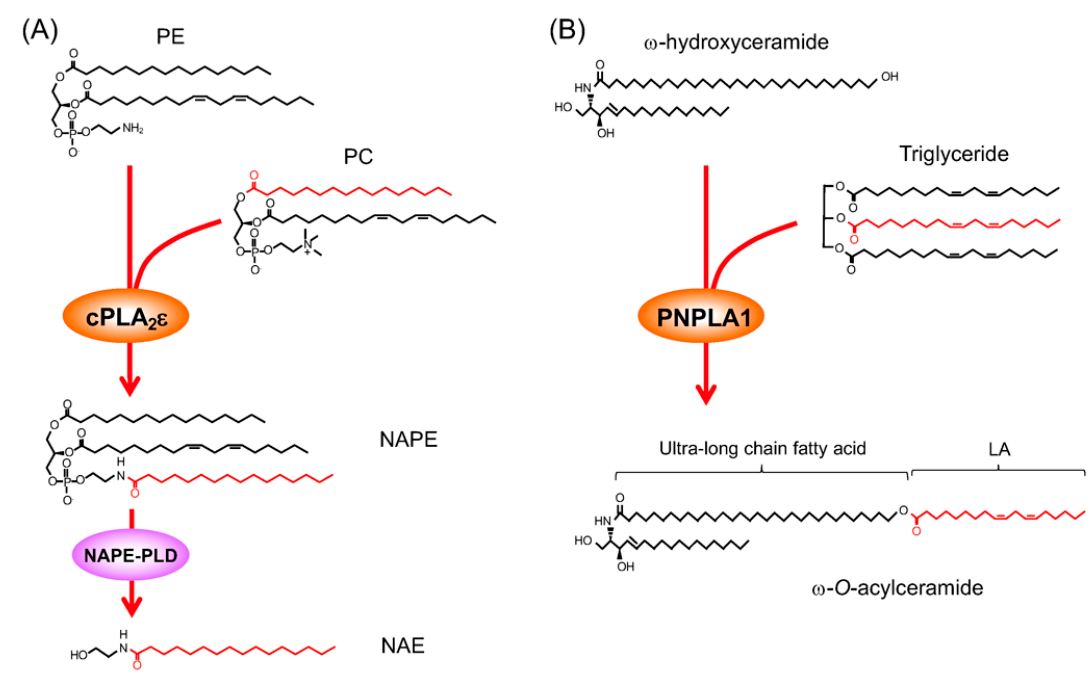
Figure 4. Examples of PLA 2 enzymes that have unique enzymatic activity. ( A ) cPLA 2 ε catalyzes an N -acyltransferase reaction, transferring the sn -1 fatty acid of PC to the amino group of PE to produce NAPE, which is then converted to NAE by NAPE-PLD. ( B ) PNPLA1 acts as a unique transacylase, transferring LA from triglyceride to ω -hydroxyceramide to give rise to ω - O -acylceramide, which is essential for skin barrier function.